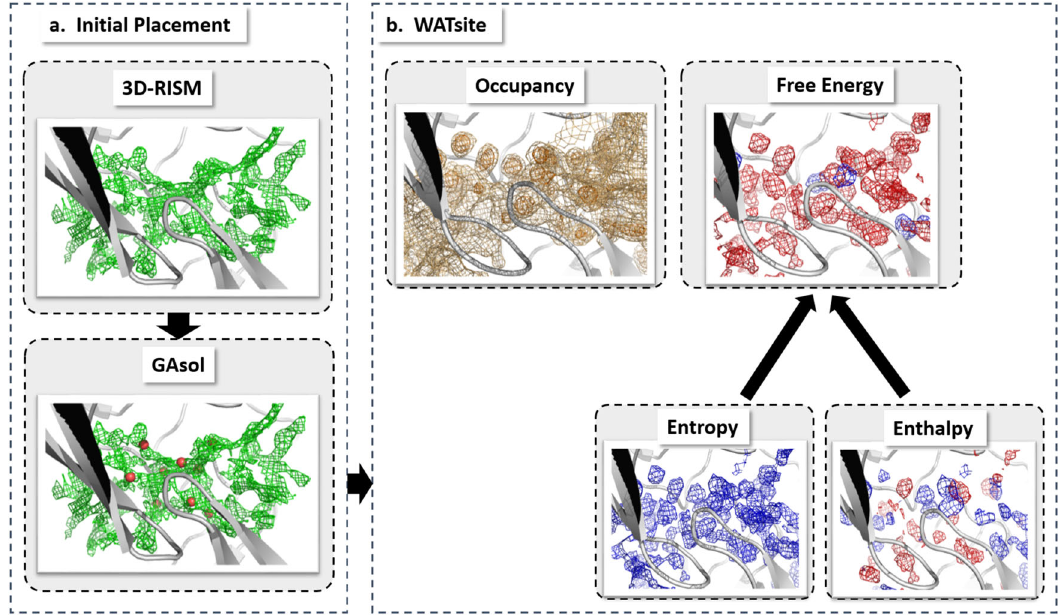
Fig. 15 Overall procedure of WATsite. Overall procedure of WATsite combining a initial placement of water molecules using 3D-RISM and GAsol, and b subsequent MD simulation with explicit water molecules and WATsite analysis to generate water occupancy, enthalpy, and entropy grids (adapted from ref. 29